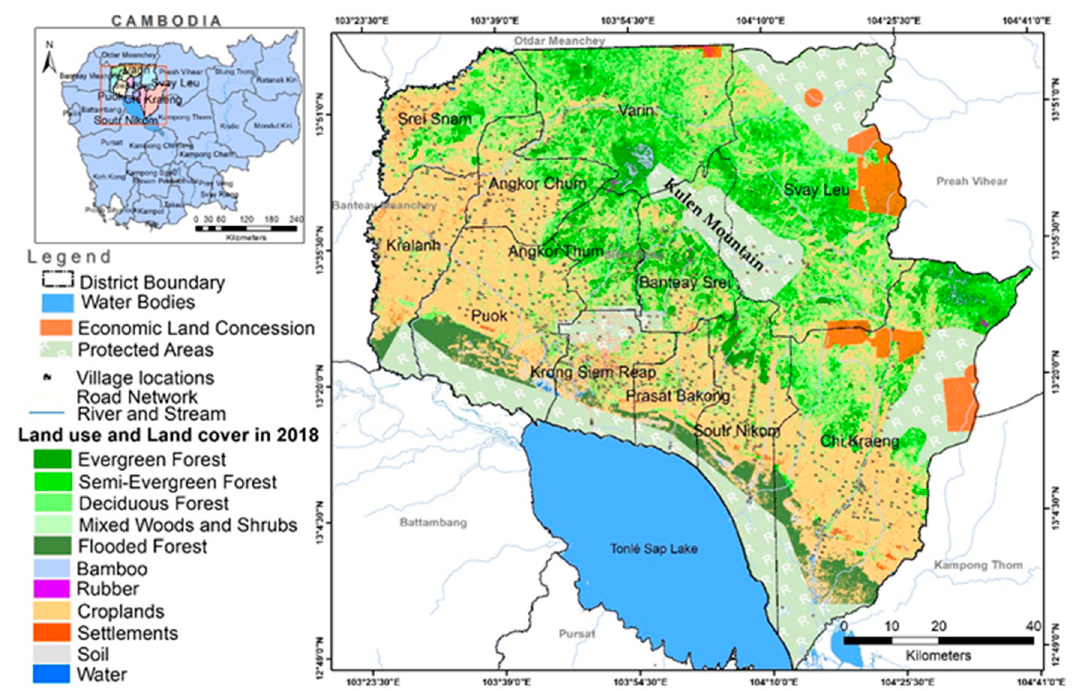
Figure 1. Major land use and land cover categories in Siem Reap province, 2018. Note: The base map data—including district boundary, water bodies, economic land concession boundaries, protected areas, village locations, road and stream network vector data—were collected from open development Cambodia [46]. The land cover map of 2018 was produced from this study.